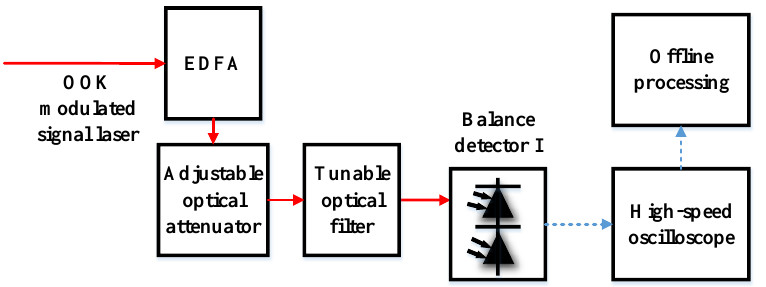
Figure 1. Experimental structure of non-coherent OOK receiver.